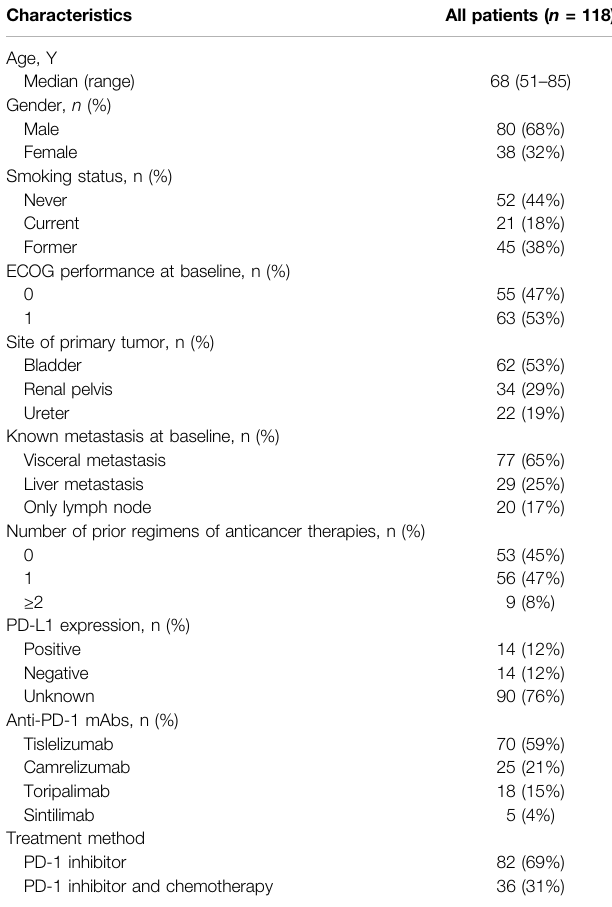
TABLE 1 | The patients ’ baseline disease